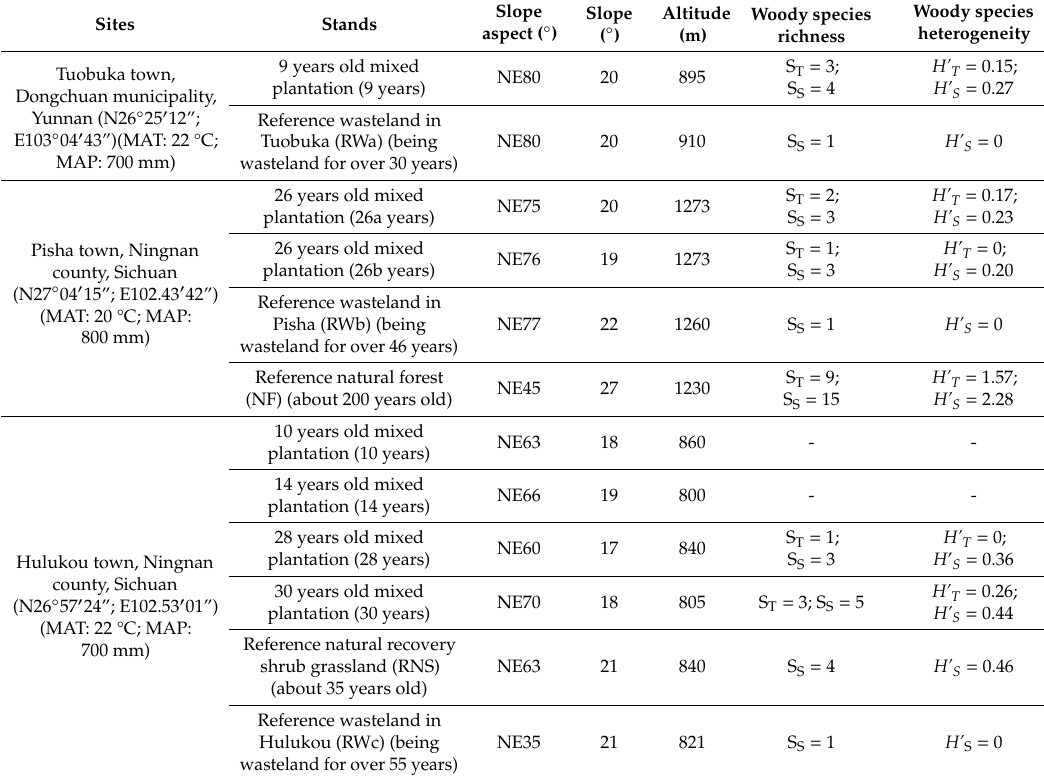
Table 1. Basic information of the stands.